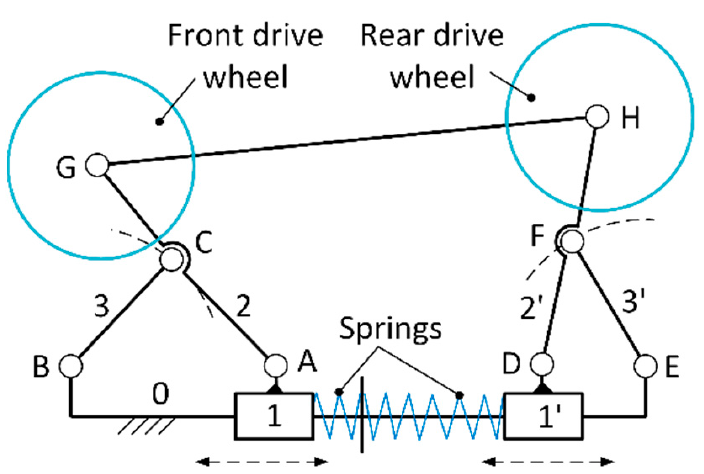
Figure 10. Adapting mechanism with inner springs.